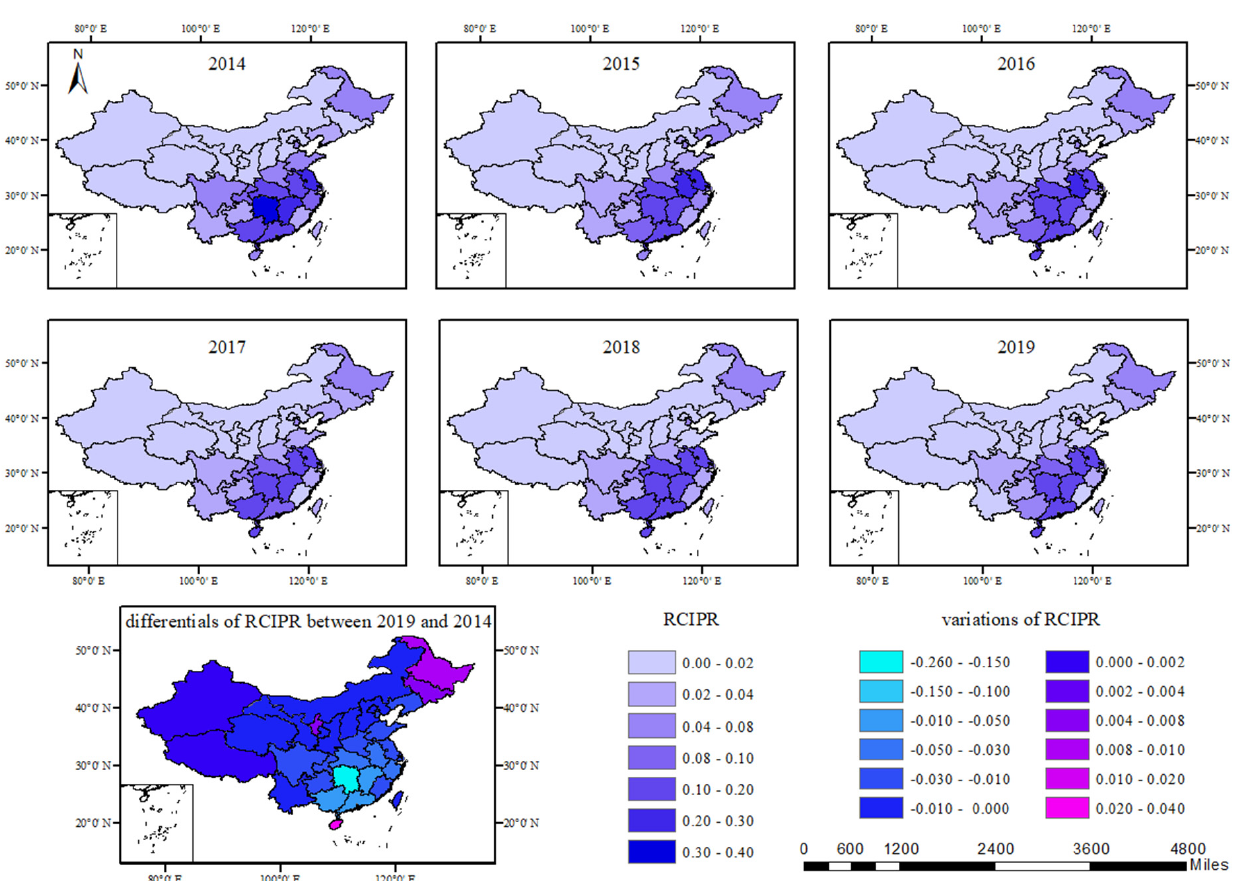
Figure 12. Regional cropping intensity for paddy rice (CIPR) in China from 2014 to 2019. The RCIPR increased in northeastern China, western China, Hainan Province (HAN), and Ningxia Hui Autonomous Region (NX), but dropped in other regions, especially in south China. In northeastern China, the increase in the price for rice and abundant water resources accelerated the expansion of single paddy rice, leading to the rise in RCIPR. In western China and NX, the paddy rice planting area was small in 2014, so the RCIPR showed a fluctuation. There was a significant increase in RCIPR from 2014 to 2019 in HAN due to the conversion of single-cropping paddy rice to double-cropping paddy rice. Regions with decreased RCIPR were concentrated in south China due to a rural labor shortage and a conflict between grain production and economic development. The RCIPR for Hunan Province dropped by 0.26 (Figure 13), followed by Jiangxi Province (0.09), Guangxi Province (0.07), and Guangdong Province (0.06), where the double paddy rice dominated the paddy rice cropping system. This is because some double paddy rice systems were converted to the single paddy rice